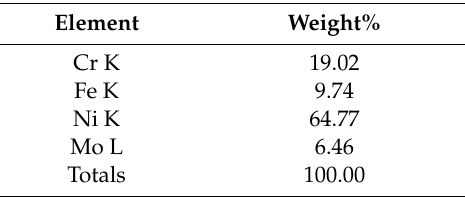
Figure 7. E Ni 6625, central part of the weld deposit, semi-quantitative EXD microanalysis. Table 4. EDX, spectrum 1.